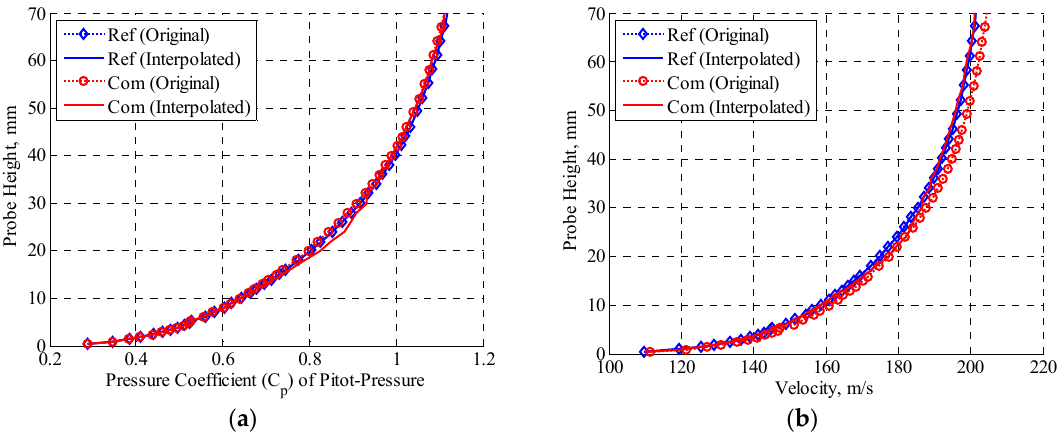
Figure 9. Comparison of profiles for smooth wall cases at two different flights (where ‘Ref’ denotes a